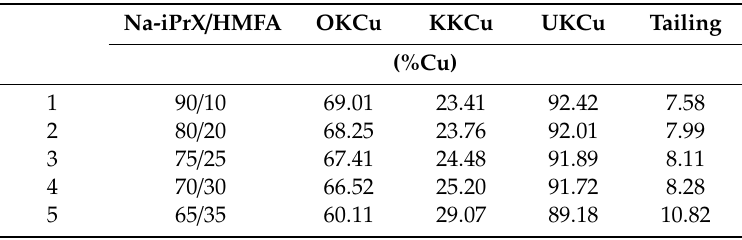
Table 7. Flotation results obtained using Na-iPrX/HMFA flotoreagent (copper content of ore—1.8515%, OKCu—basic flotation (first flotation step), KKCu—extended flotation (second flotation step), UKCu—total floated copper, tailing—residual content of copper).